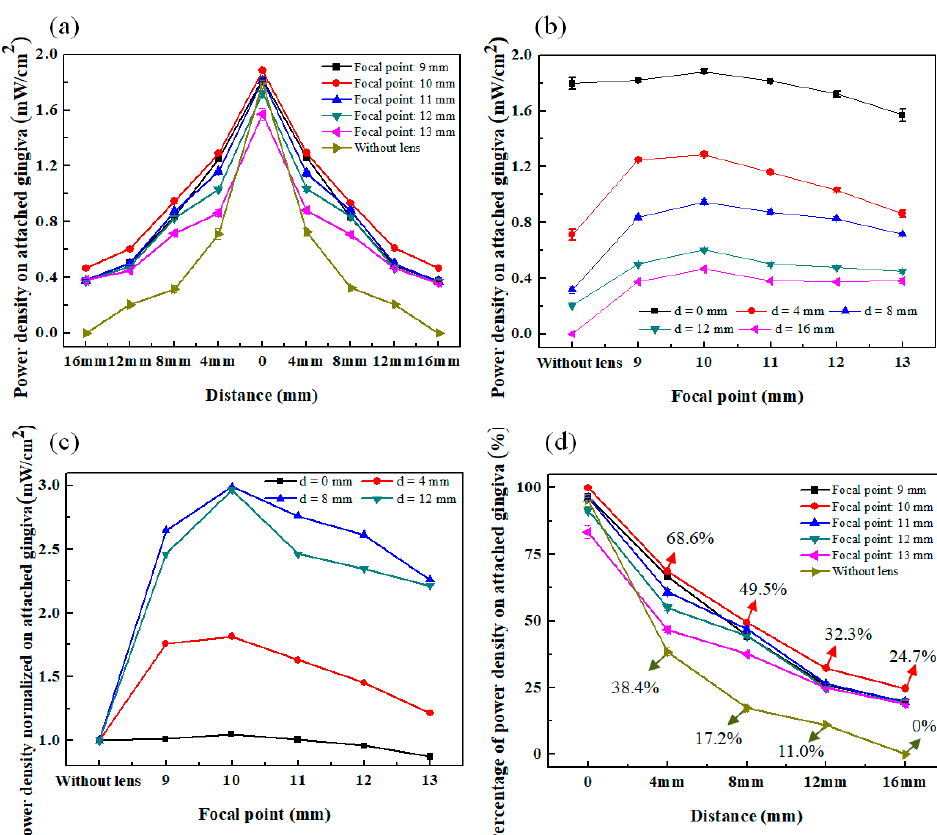
Figure 5. ( a ) Power densities distribution of the 830 nm laser penetrates the orbicularis oris with different focal points on the attached gingiva. ( b ) Power densities of the 830 nm laser on the attached gingiva versus different focal points. ( c ) Normalized power densities of the 830 nm laser on the attached gingiva versus different focal points. ( d ) Percentage of power densities decay on the attached gingiva from 0 mm to 16 mm.